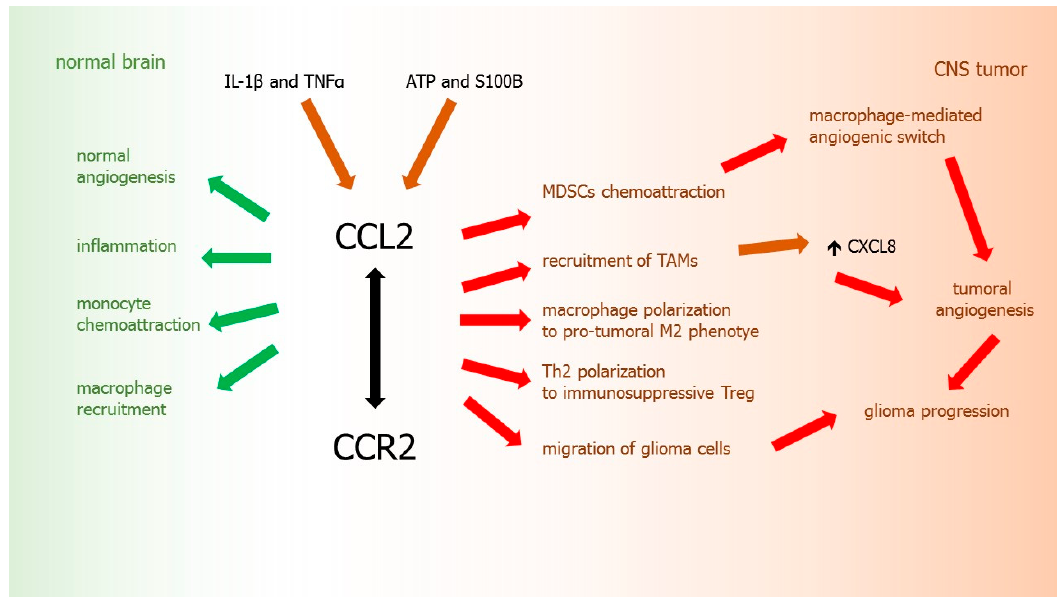
Figure 5. CCL2-CCR2 axis in glioma development. Green arrows: chemokine activity in normal brain tissues, red arrows: chemokine activity in glioma, brown arrows: factors inducing chemokine, black arrow: chemokine-receptor axis.